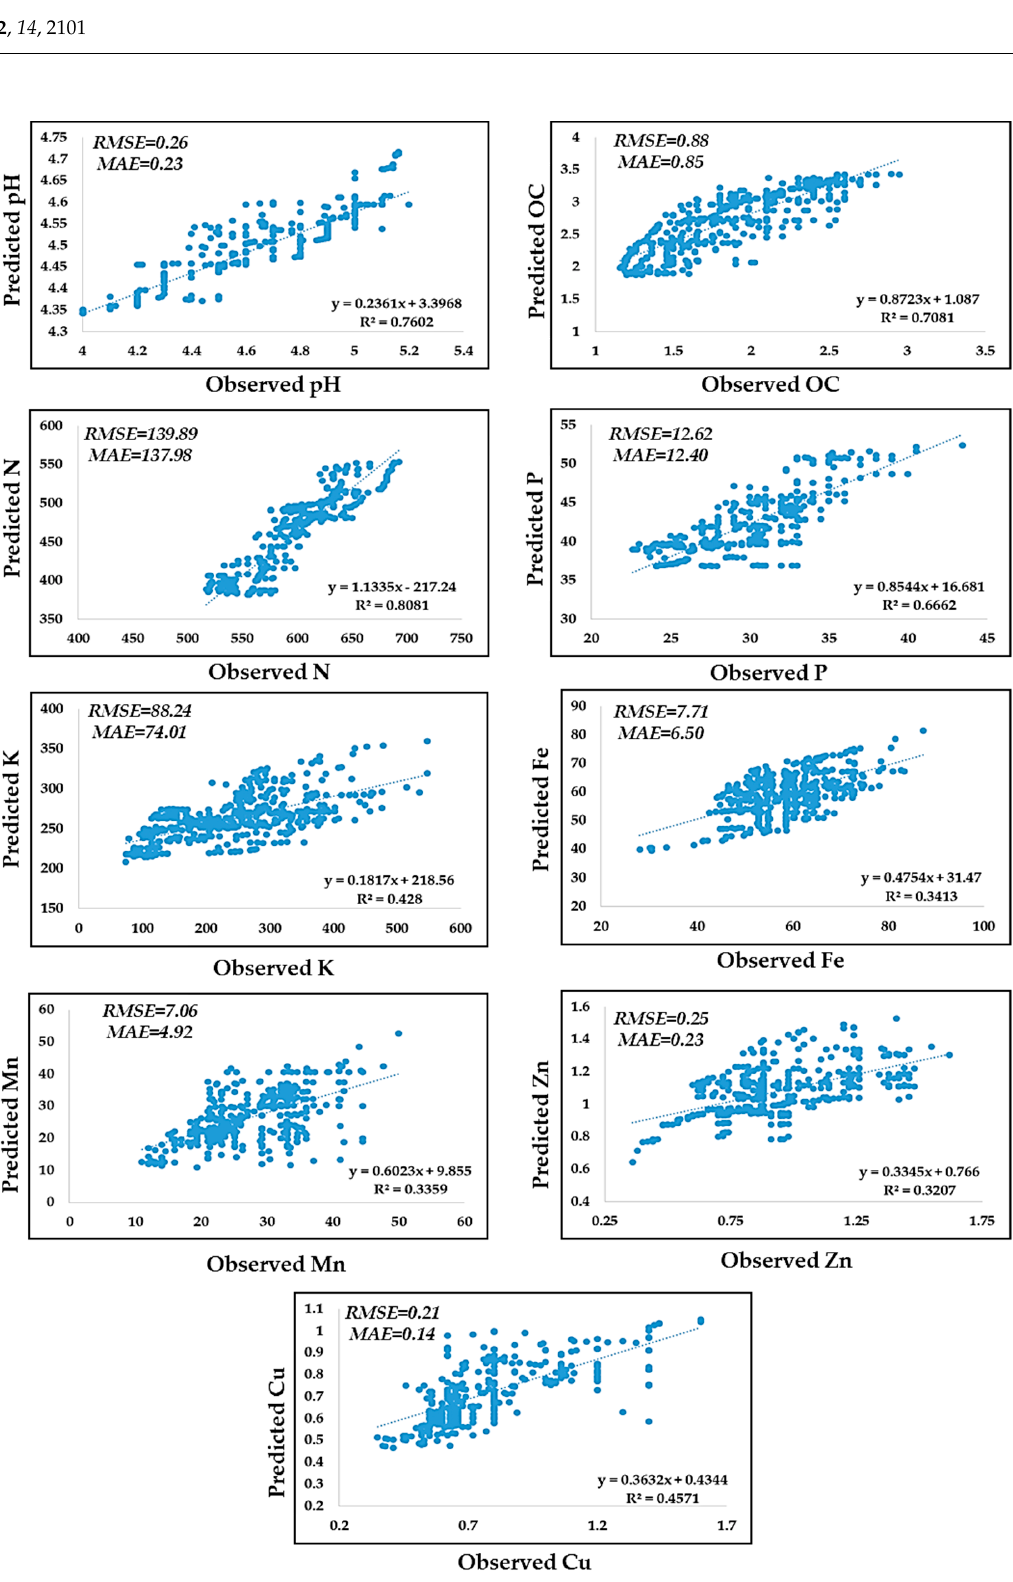
Figure 4. Validation of soil properties and available nutrients with current available datasets. pH; OC, soil organic carbon; N, available nitrogen; P, available phosphorus; K, available potassium; Fe, Mn, Zn and Cu represent DTPA-extractable iron, manganese, zinc and copper in soil, respectively. The predicted maps of the studied soil properties (pH, OC, available N, P, K, Fe, Mn, Zn and Cu) in the surface soil using stepwise multiple regression kriging are presented in Figure 5. The predicted soil reaction (pH) varied from 4–5 and soil organic carbon varied from 0.4 to 3.7. The predicted macronutrients viz., N, P and K varied from 268.9 to 652.8 kg ha − 1 , 31 to 78.8 kg ha − 1 and 112.6 to 139.0 kg ha − 1 , respectively. Similarly, in the case of